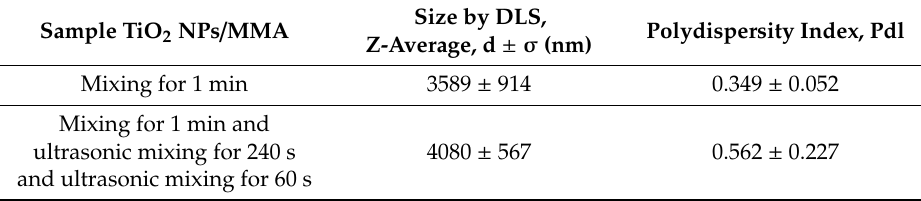
Table 4. Average diameter of TiO 2 NPs in a methyl methacrylate suspension, Cp = 0.01 wt%.